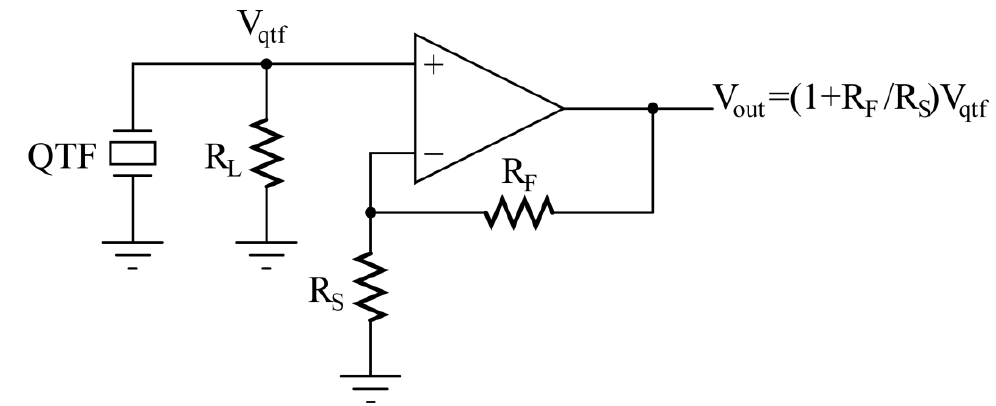
Figure 2. Voltage-mode read-out of the QTF (OPAMP in non-inverting configuration).